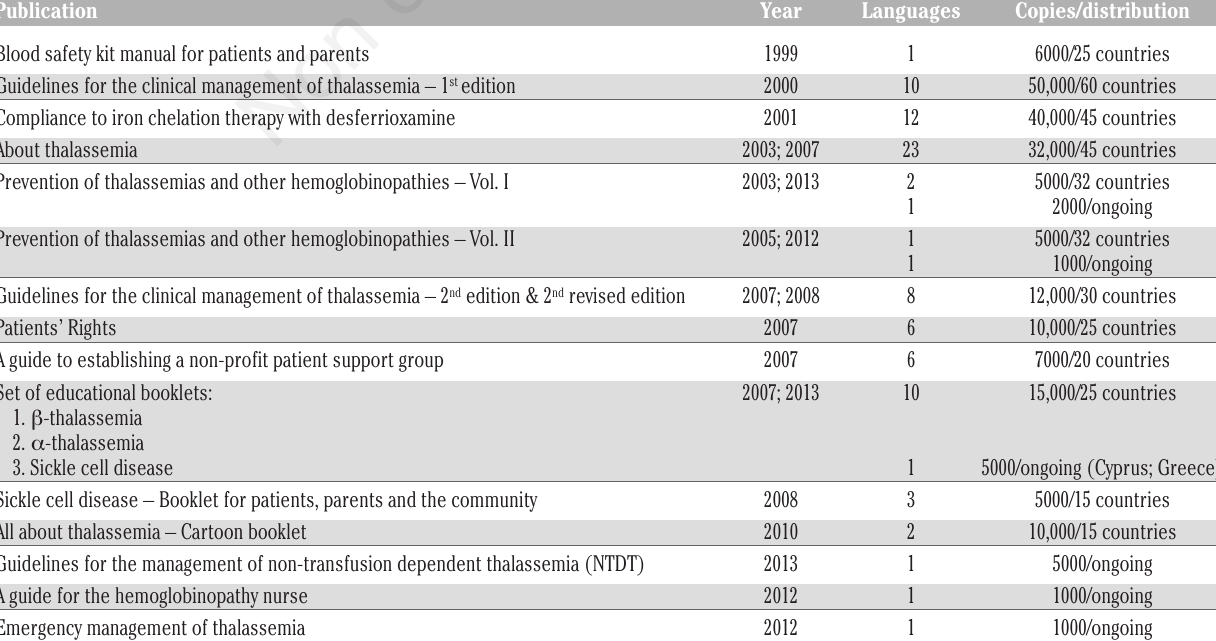
Table 1. Thalassemia International Federation: educational